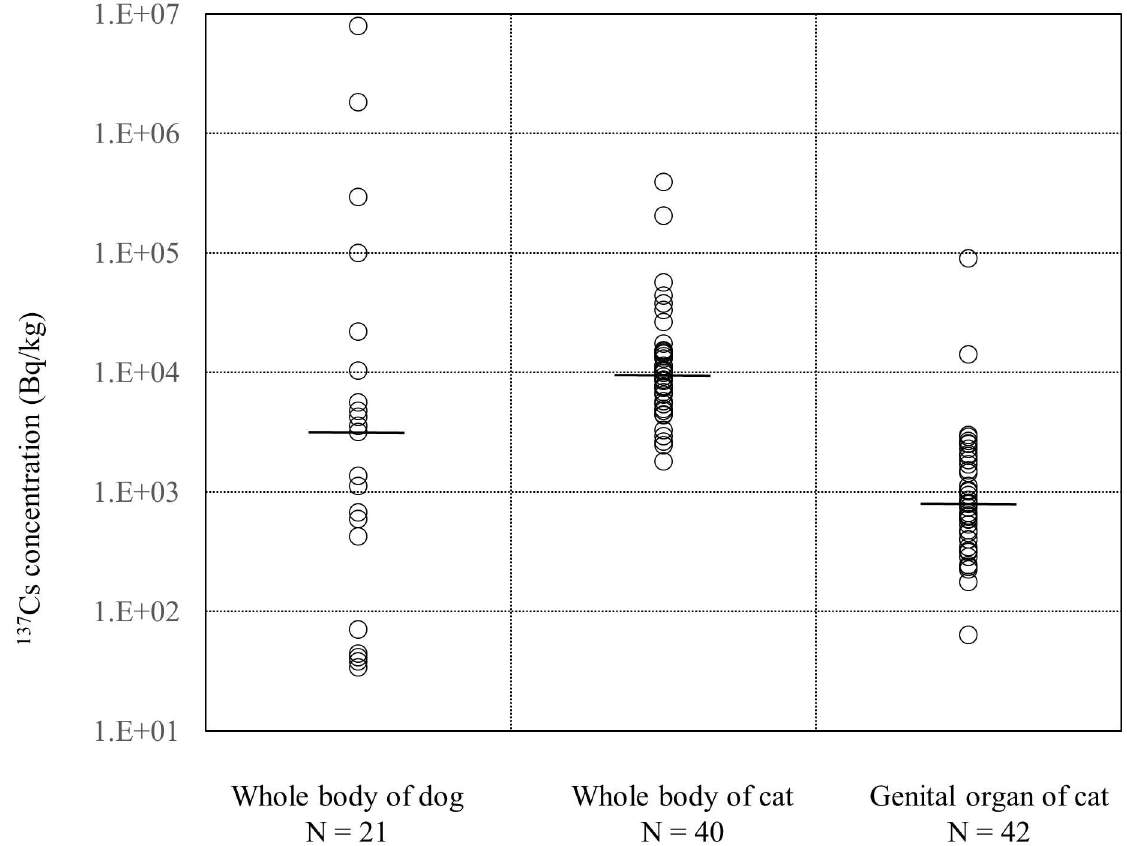
Fig 6. 137 Cs concentrations of canine whole-bodies, feline whole-bodies, and feline genital organs. The whole-body concentrations and genital concentrations were corrected to the time caught, using the effective half-life values. Horizontalshort bars show the